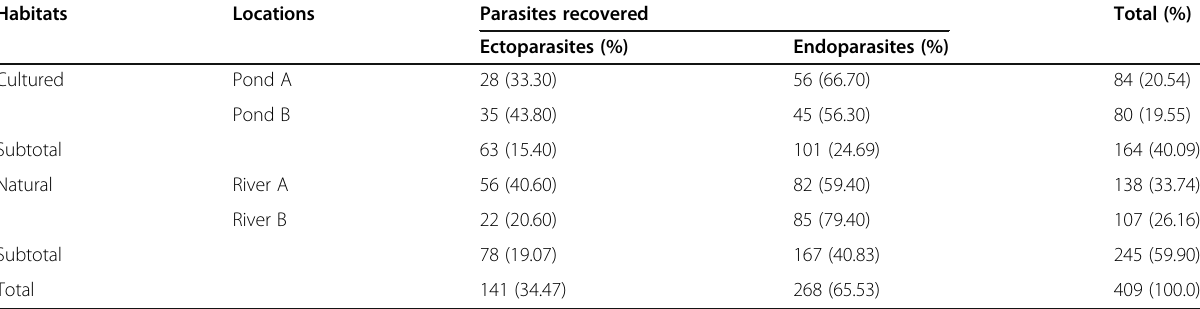
Table 2 Comparison of the catfish parasites in natural and cultured habitats Habitats